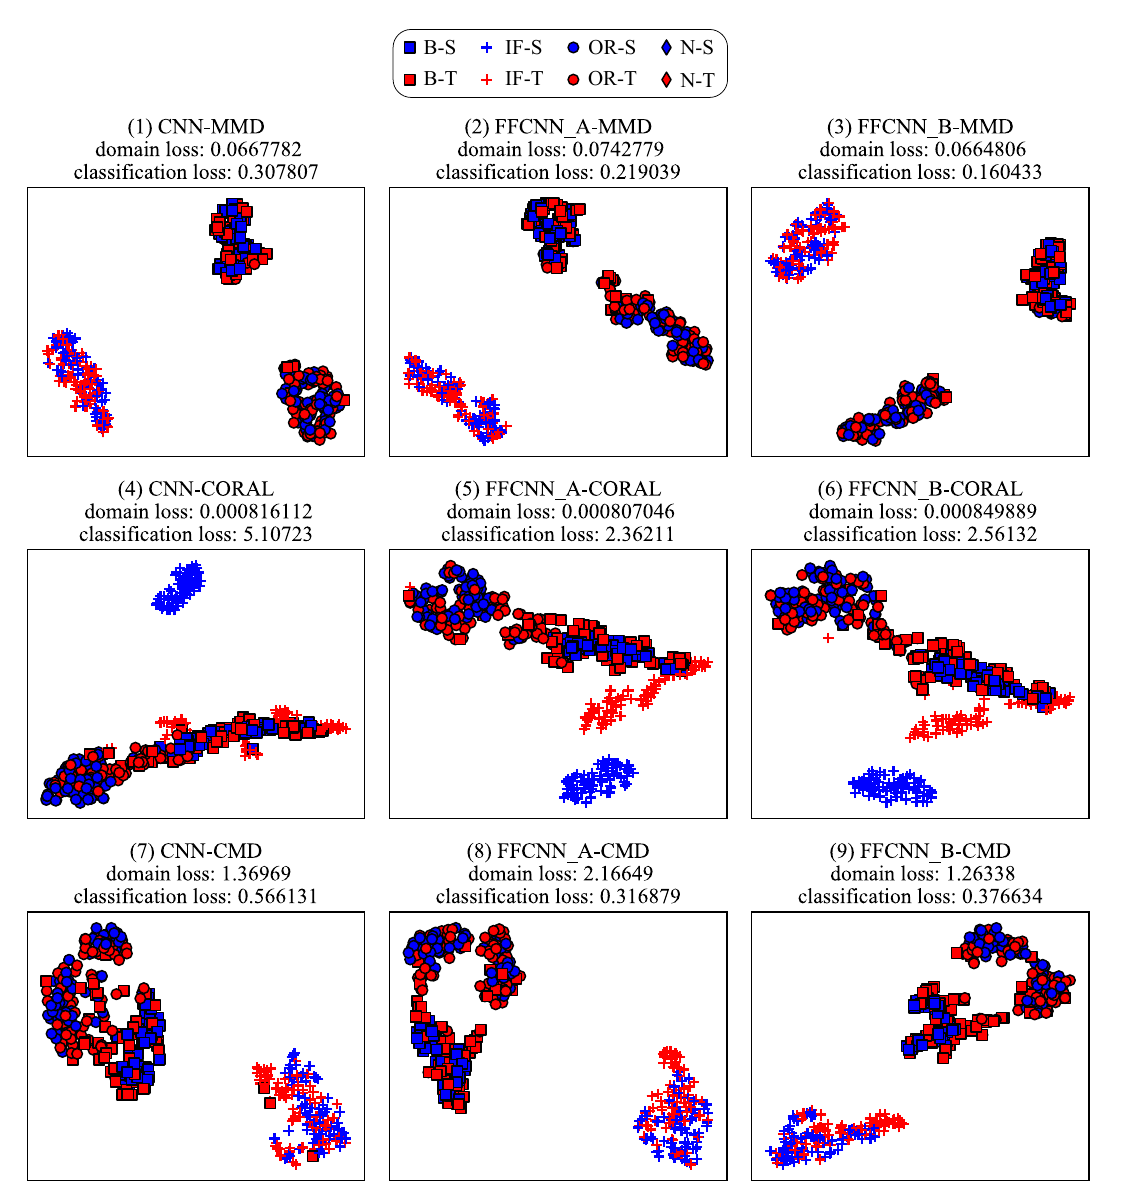
Figure 12. The visualization of learned features on Paderborn dataset. The blue markers represent the source domain, the red markers represent the target domain. They are obtained from task P 3 → P